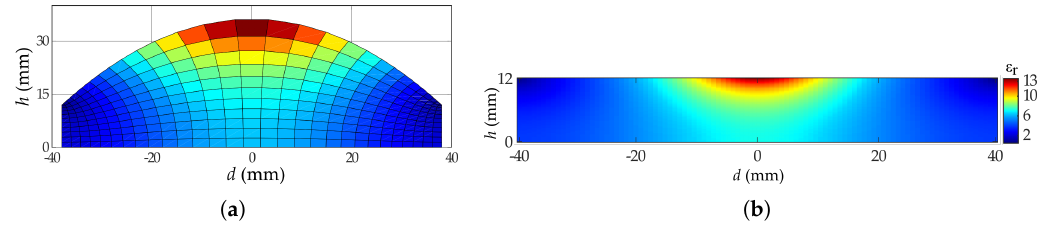
Figure 2. Transformation optics for the canonical hyperbolic lens. ( a ) Grid of the hyperbolic lens (colors indicate the surface difference between grids). ( b ) Transformed flat lens with relative permittivity ( ε r )